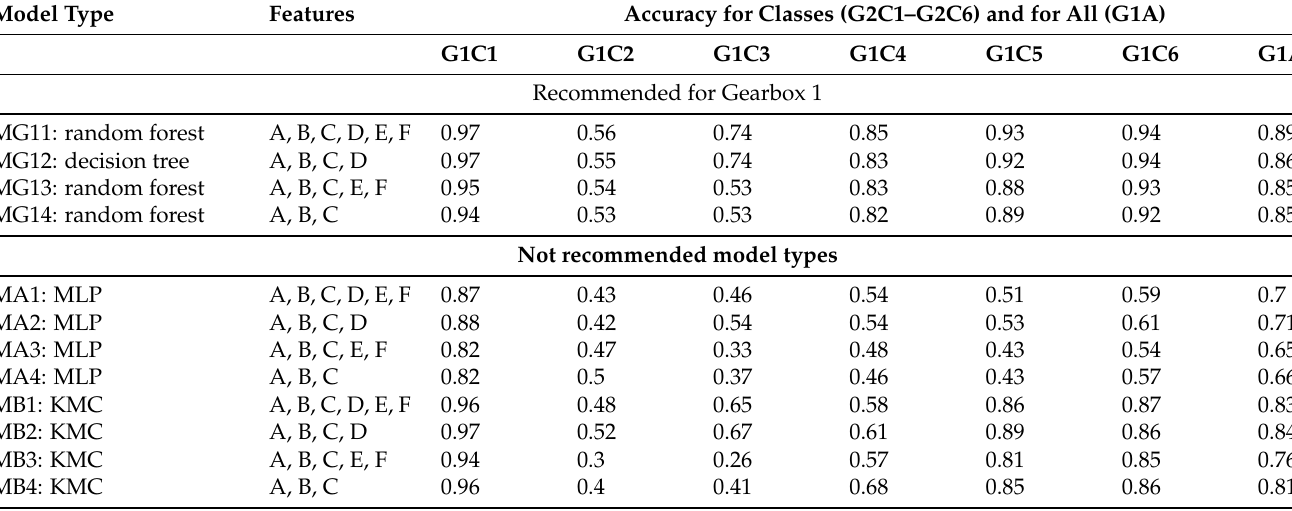
Table 7. Model accuracy for Gearbox